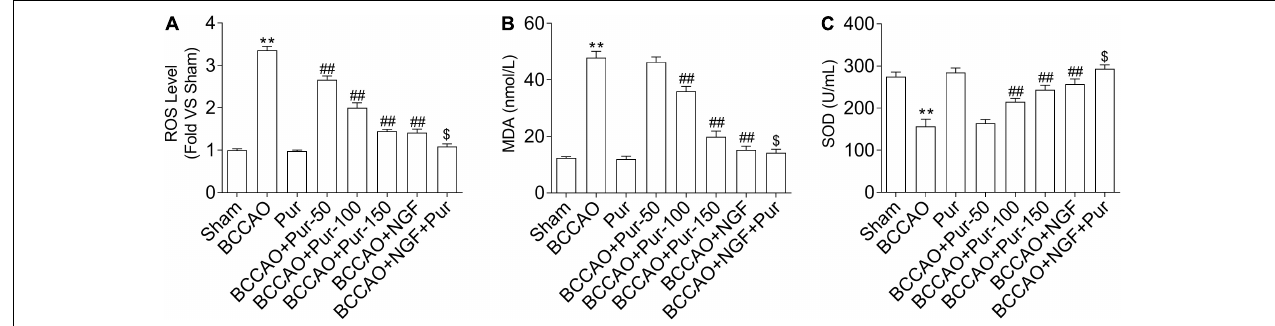
FIGURE 6 | Effect of Pur on (A) ROS, (B) MDA, and (C) SOD levels in experimental rats. Results were mean ± SEM ( n = 6). ** P < 0.01 vs. Sham; ## P < 0.01 vs. BCCAO; $ P < 0.05 vs. BCCAO + Pur (150 mg/kg/day).